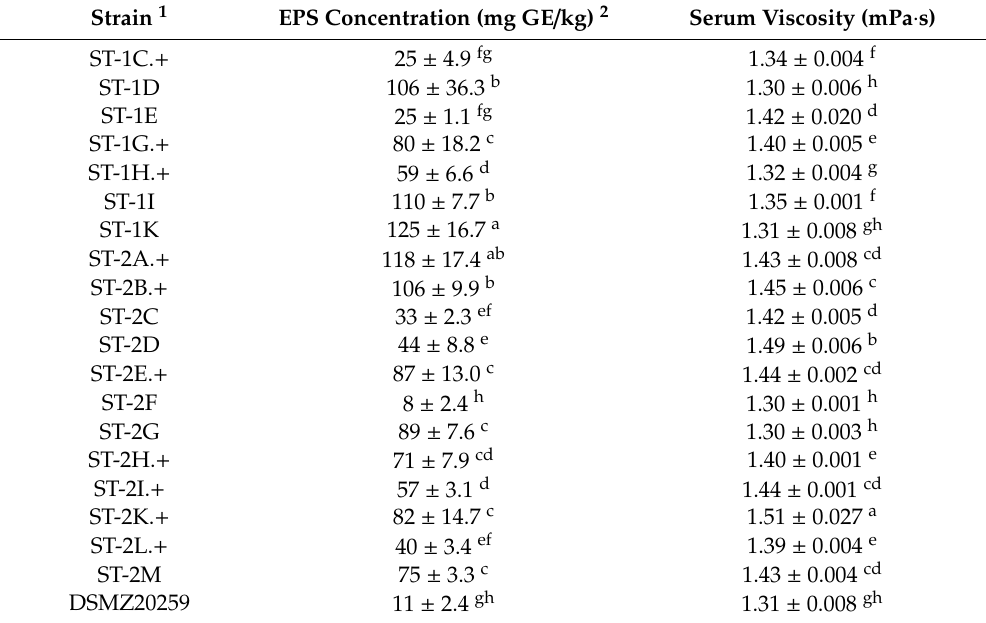
Table 1. Exopolysaccharide (EPS) concentration in reconstituted skim milk fermented with Streptococcus thermophilus (ST) strains, and corresponding serum